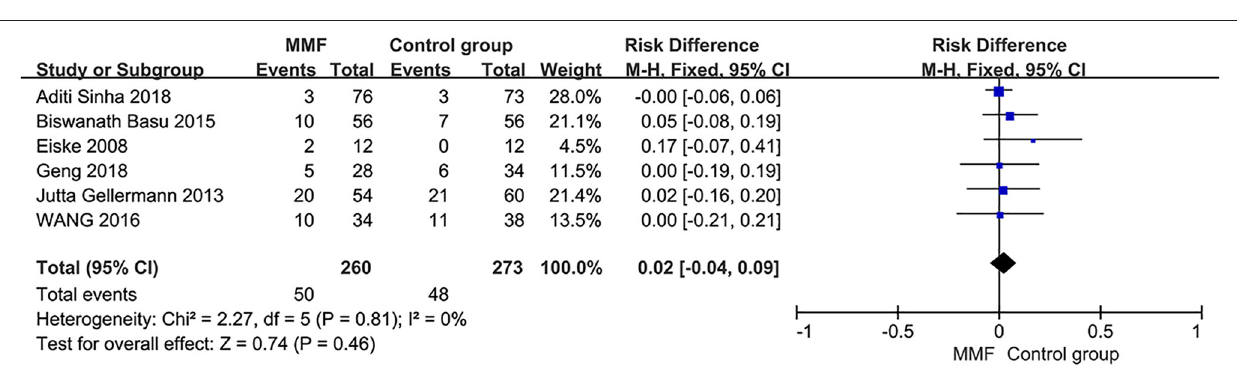
FIGURE 6 | Forest plot showing ratio difference (RD) of the incidence of adverse reactions between the